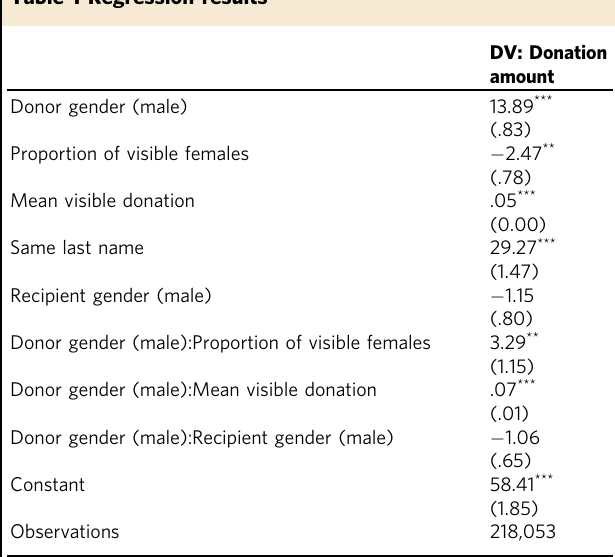
Table 1 Regression results